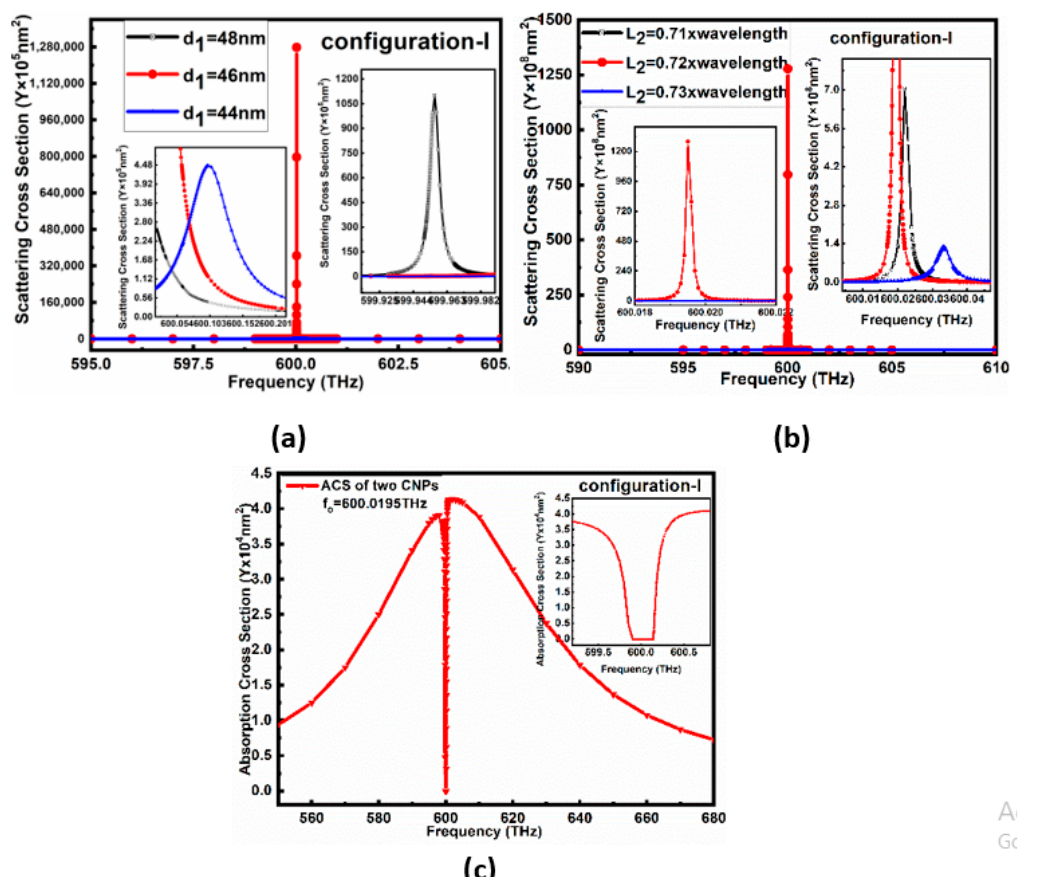
Figure 2. shows scattering cross-section (SCS) and absorption cross-section (ACS) for configuration I varies with different size: ( a ) SCS varies with the core diameter d 1 of CNP for configuration-I. ( b ) SCS (127.79 × 10 9 nm 2 ) varies with the interval L 2 between two CNPs in case of configuration-I, ( c ) ACS (4.5 × 10 4 nm 2 ) for configuration-I corresponding to L 2 = 0.72 λ